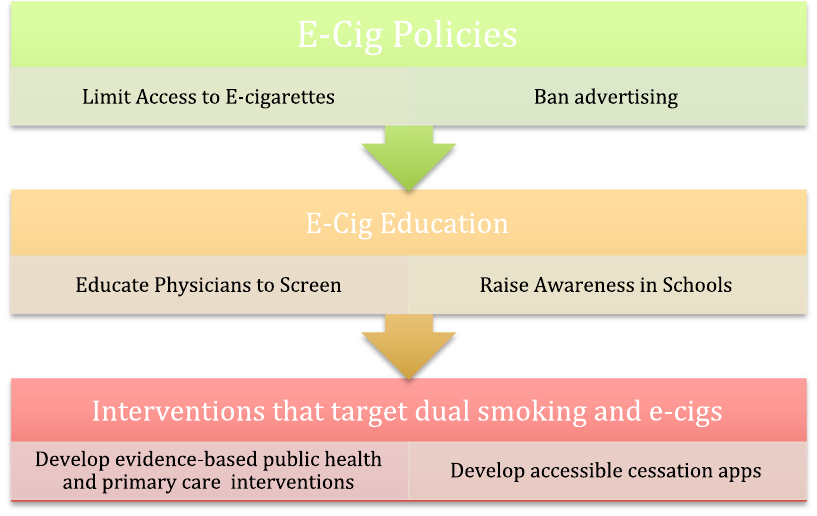
Fig. 6 A three-tiered approach to managing e-cigarette use in minors 126 . The following fi gure illustrates a three-tiered approach to managing e-cigarette use in minors, which includes policy changes, awareness, and prevention campaigns, and fi nally public health interventions that target existing teenage